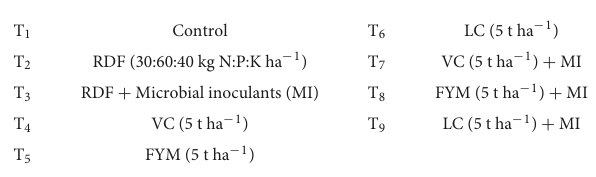
TABLE 2 Treatment details of the experiment.